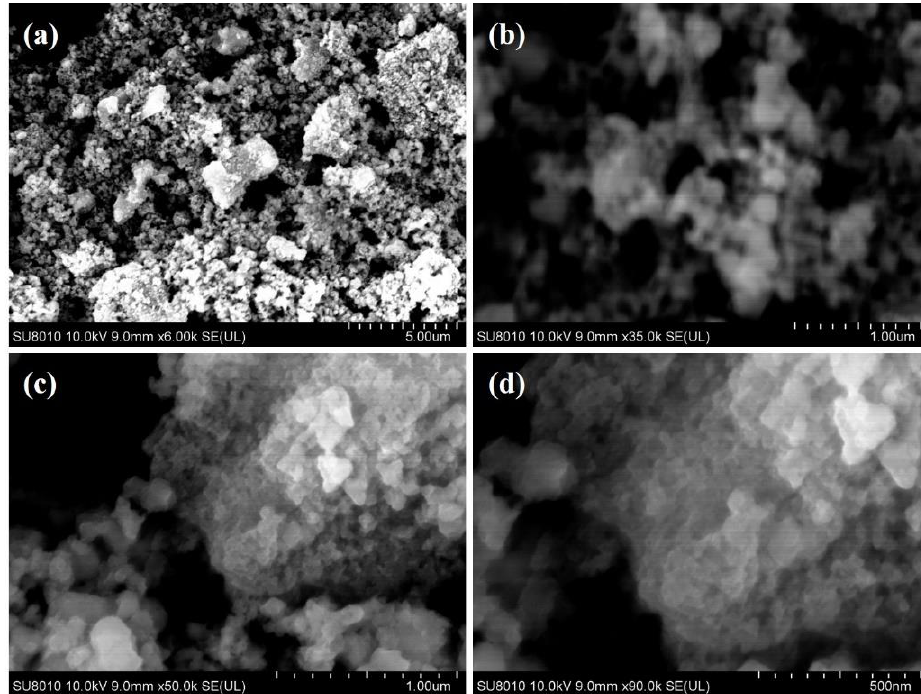
Figure 3. ( a – d ) SEM images of NiCdTiO 2 nanocomposite.